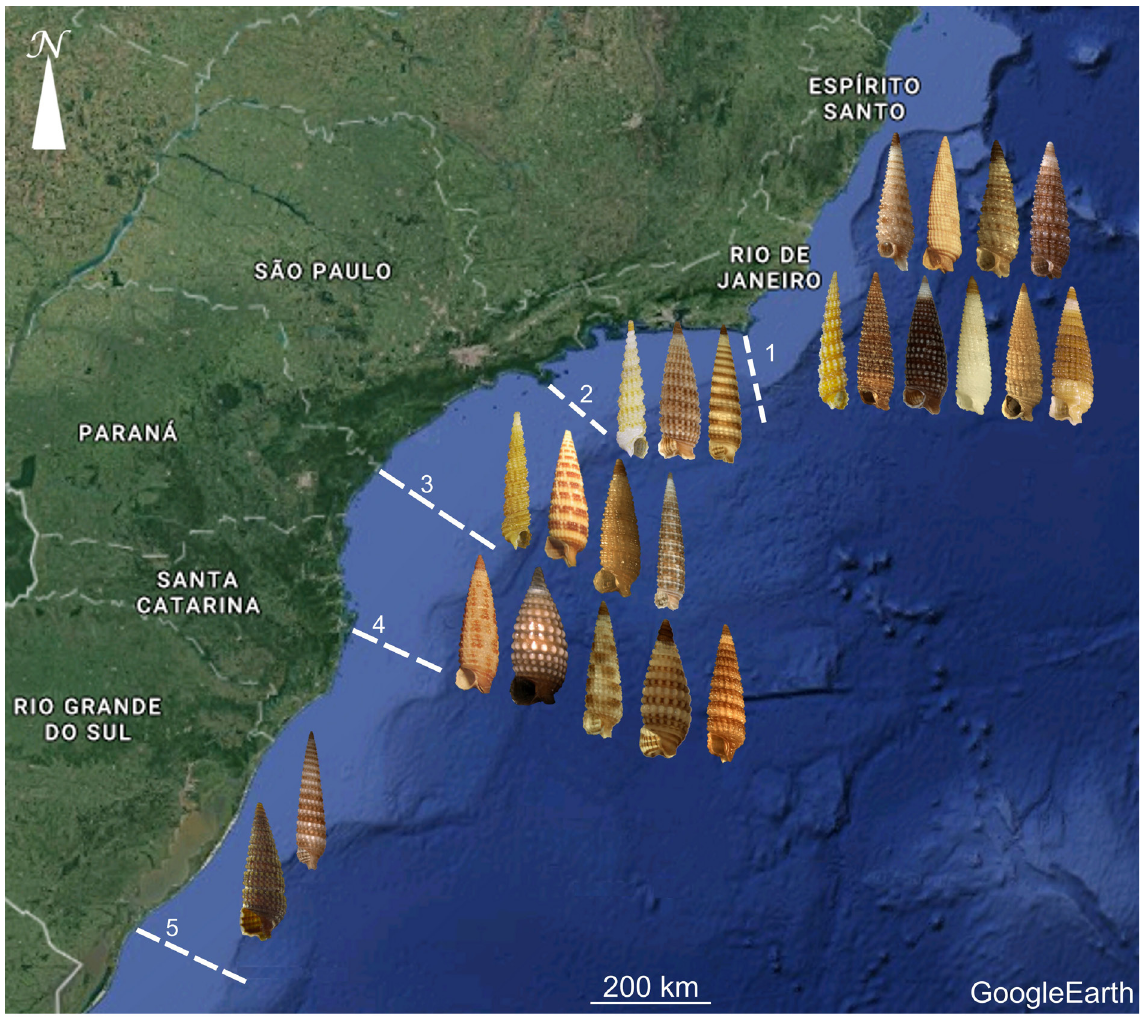
Fig. 83. Southern limits of planctotrophic, wide-range and tropical shallow-water triphorids from Brazil; the single exception is the lecithotrophic (but with a probable planctonic larva) Metaxia rugulosa (C.B. Adams, 1850) . Illustrated shells are not necessarily from the southernmost end of their range. Species are cited from the left to the right, beginning with those situated at the top of each